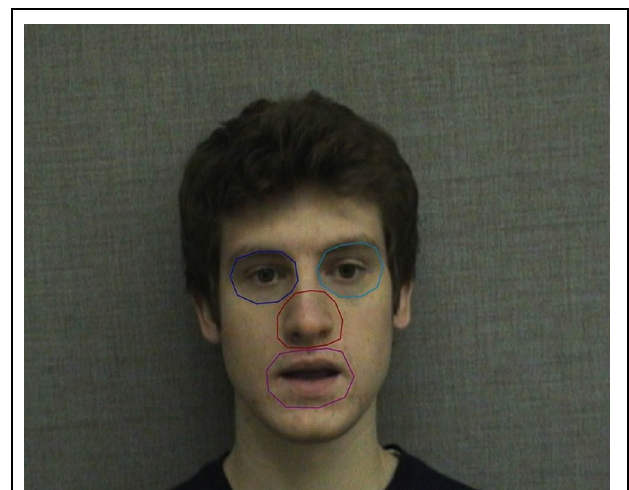
FIGURE 1 | Areas of interest (AOIs) used in eye gaze analysis. AOIs correspond to the subjects’ perspective and include the left eye (speaker’s right eye), right eye (speaker’s left eye), nose, and